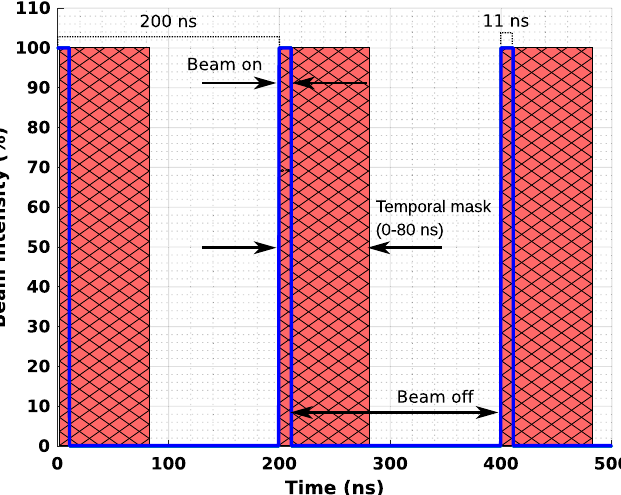
Figure 2. The micro-structure of the beam during the first 500 ns. This pattern is repeated for the entire irradiation period. The red hashed region indicates the range of the timing mask, during which events are rejected; events occurring outside of this range will be